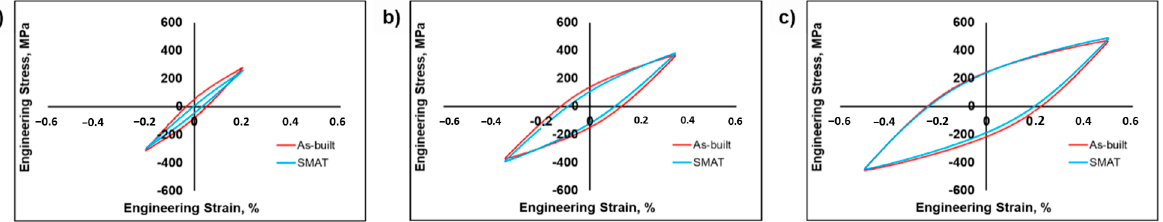
Figure 10. Half-life hysteresis loops for the DED SS 316L in as-built and SMAT processed conditions for total strain amplitudes of ( a ) Δε t /2 = ±0.2%, ( b ) Δε t /2 = ±0.35% and ( c ) Δε t /2 = ±0.5%.